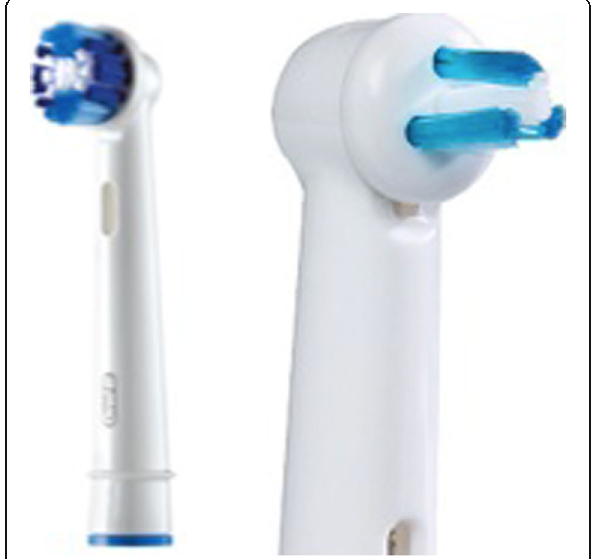
Fig. 1 Electric toothbrush heads: on the left is the one designed for natural teeth, and on the right is the one designed for dental